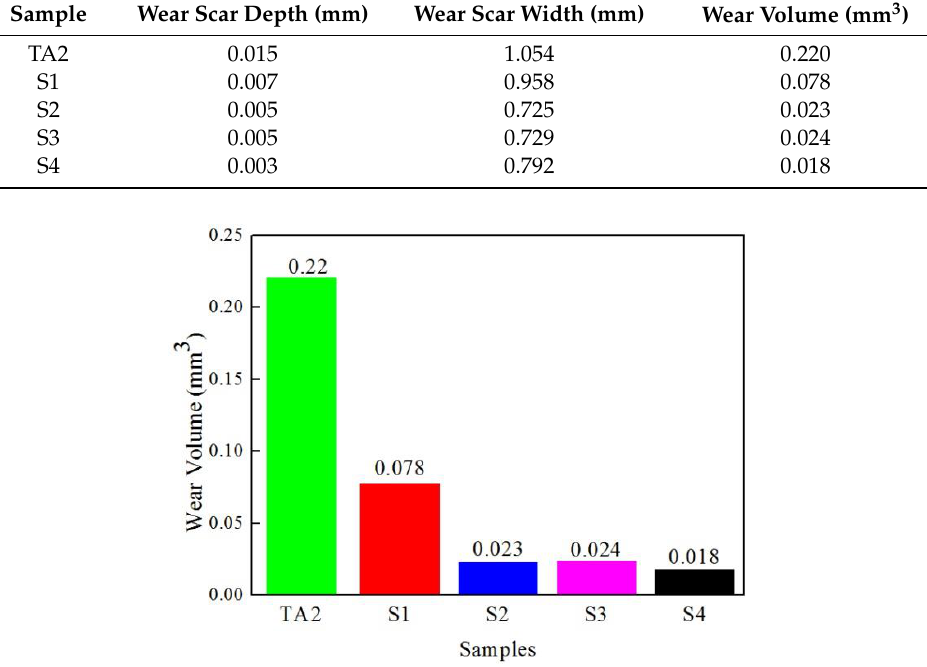
Figure 11. Wear scar profile curves of samples S1–S4 and TA2. Table 5. Geometry parameters of the wear scar profile and the calculated wear volumes.